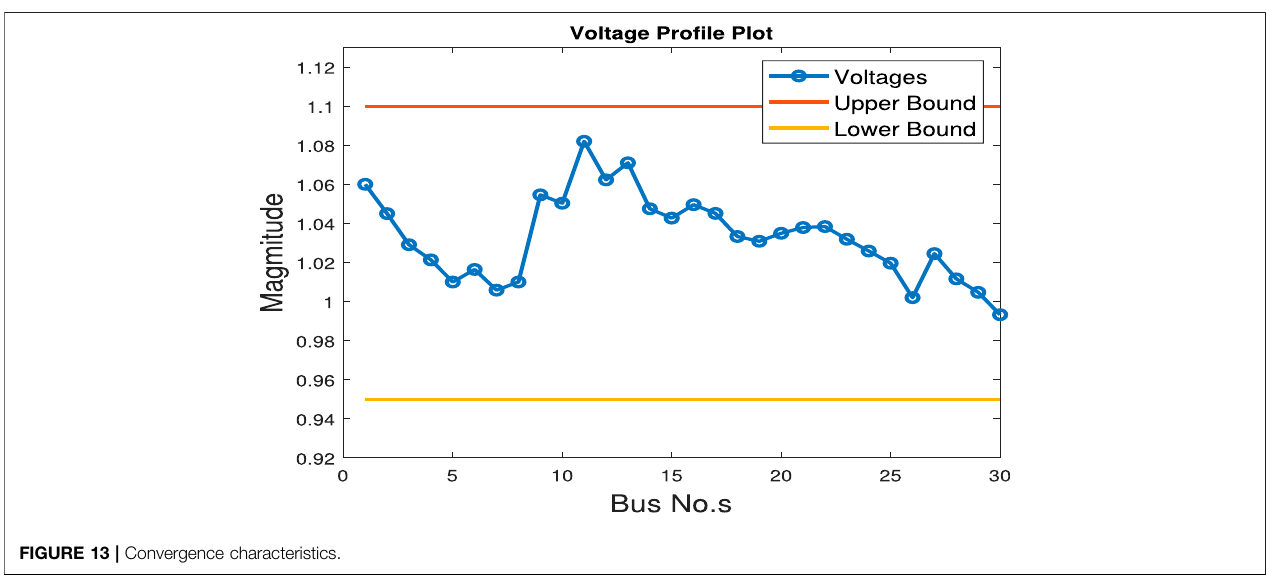
FIGURE 13 | Convergence characteristics.